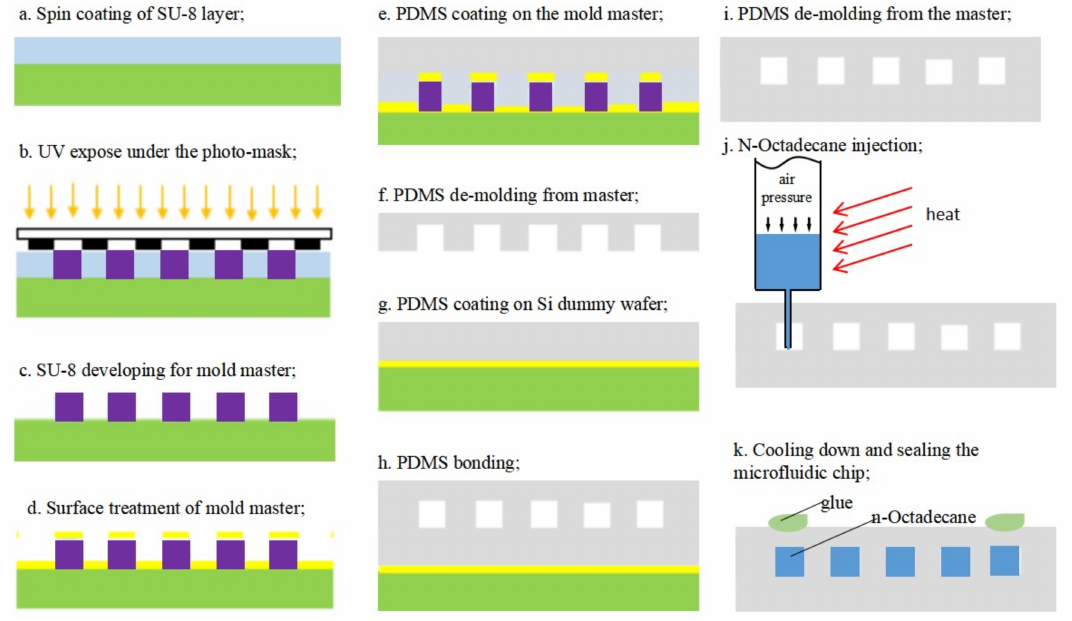
Figure 2. The fabrication process for the microfluidic device, including the master mold fabrication ( a – d ); PDMS microchannels ( e – i ); and the injection of phase-change material ( j , k